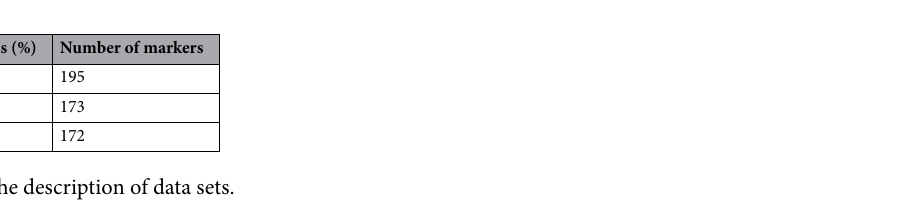
Table 1. The description of data